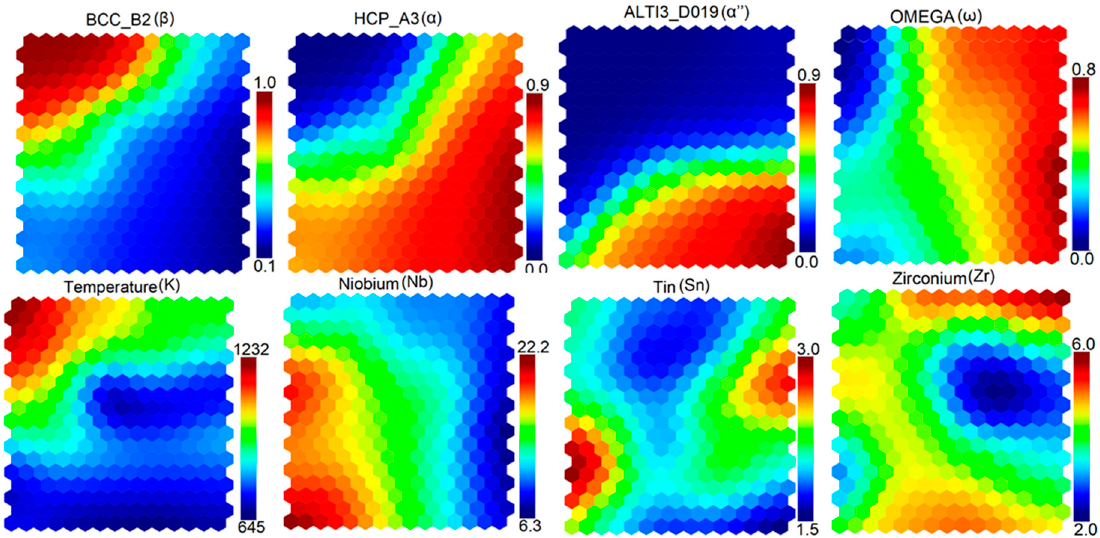
Figure 3. SOM plot showing chemical concentrations, temperatures and resulting stable and metastable phases for the Ti-Nb-Zr-Sn system.